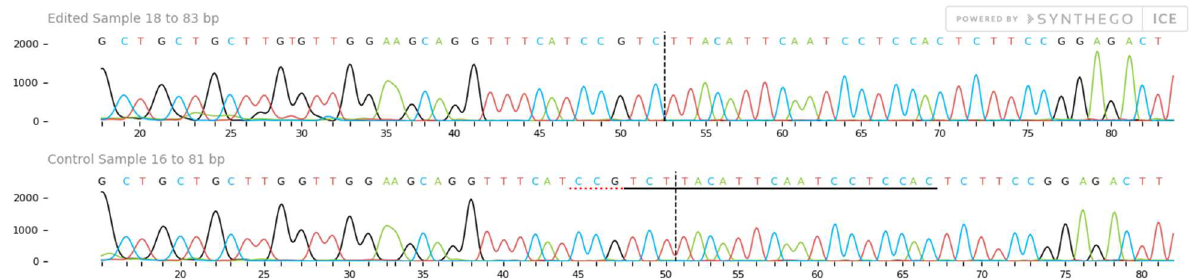
Figure 6. Traces of the edited and control population of the protoplast as shown by the Sanger Scheme 1. files control and the experimental study, which contain mixed base call. The region underlined in horizontal black represents the guide sequence. The PAM site is represented as the horizontal red focus. The vertical dotted black line represents the site of the actual break. Cutting and fixing which is sensitive to errors usually results in mixed sequencing bases after cutting.